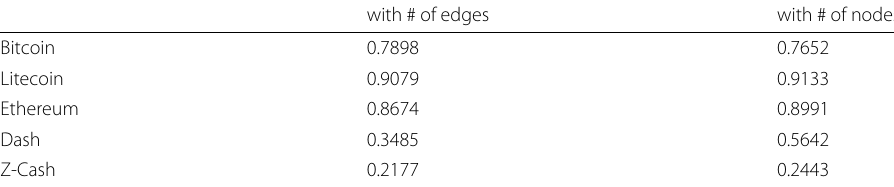
Table 1 Correlation of price with size of MTG graph with # of edges with # of nodes Bitcoin 0.7898 0.7652 Litecoin 0.9079 0.9133